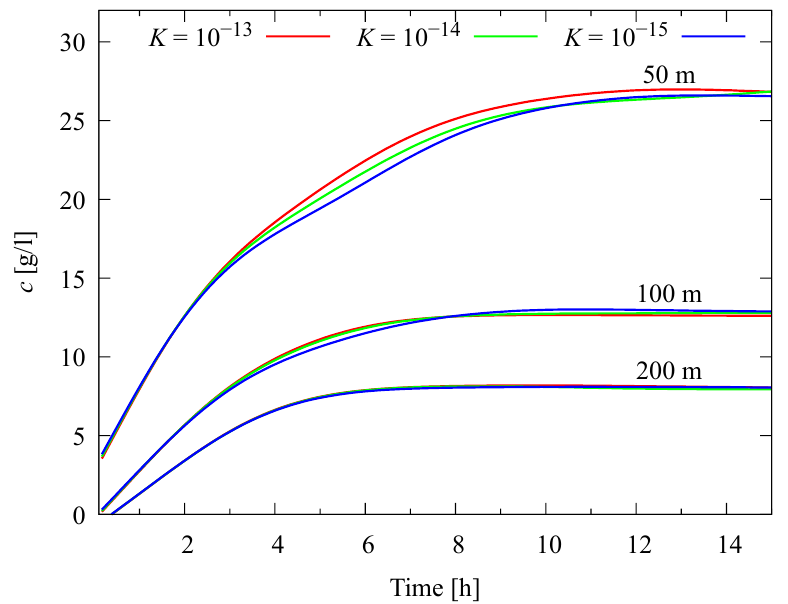
Figure 10. Evolution of the salt concentration at 2 m deep inside the hyporheic zone of 4 m total depth at distances of 50, 100 and 200 m from the brine source for different permeabilities of the porous